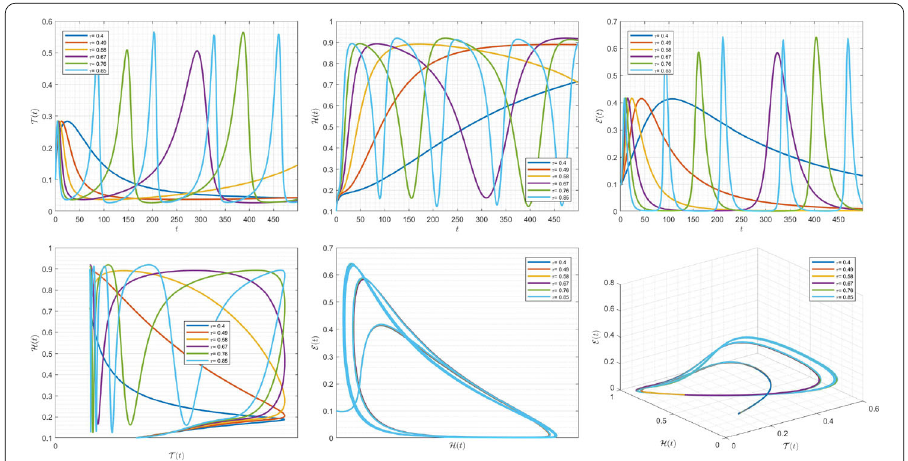
Figure 16 Simulations for solving (75) using (79) along with ( T (0), H (0), E (0)) =